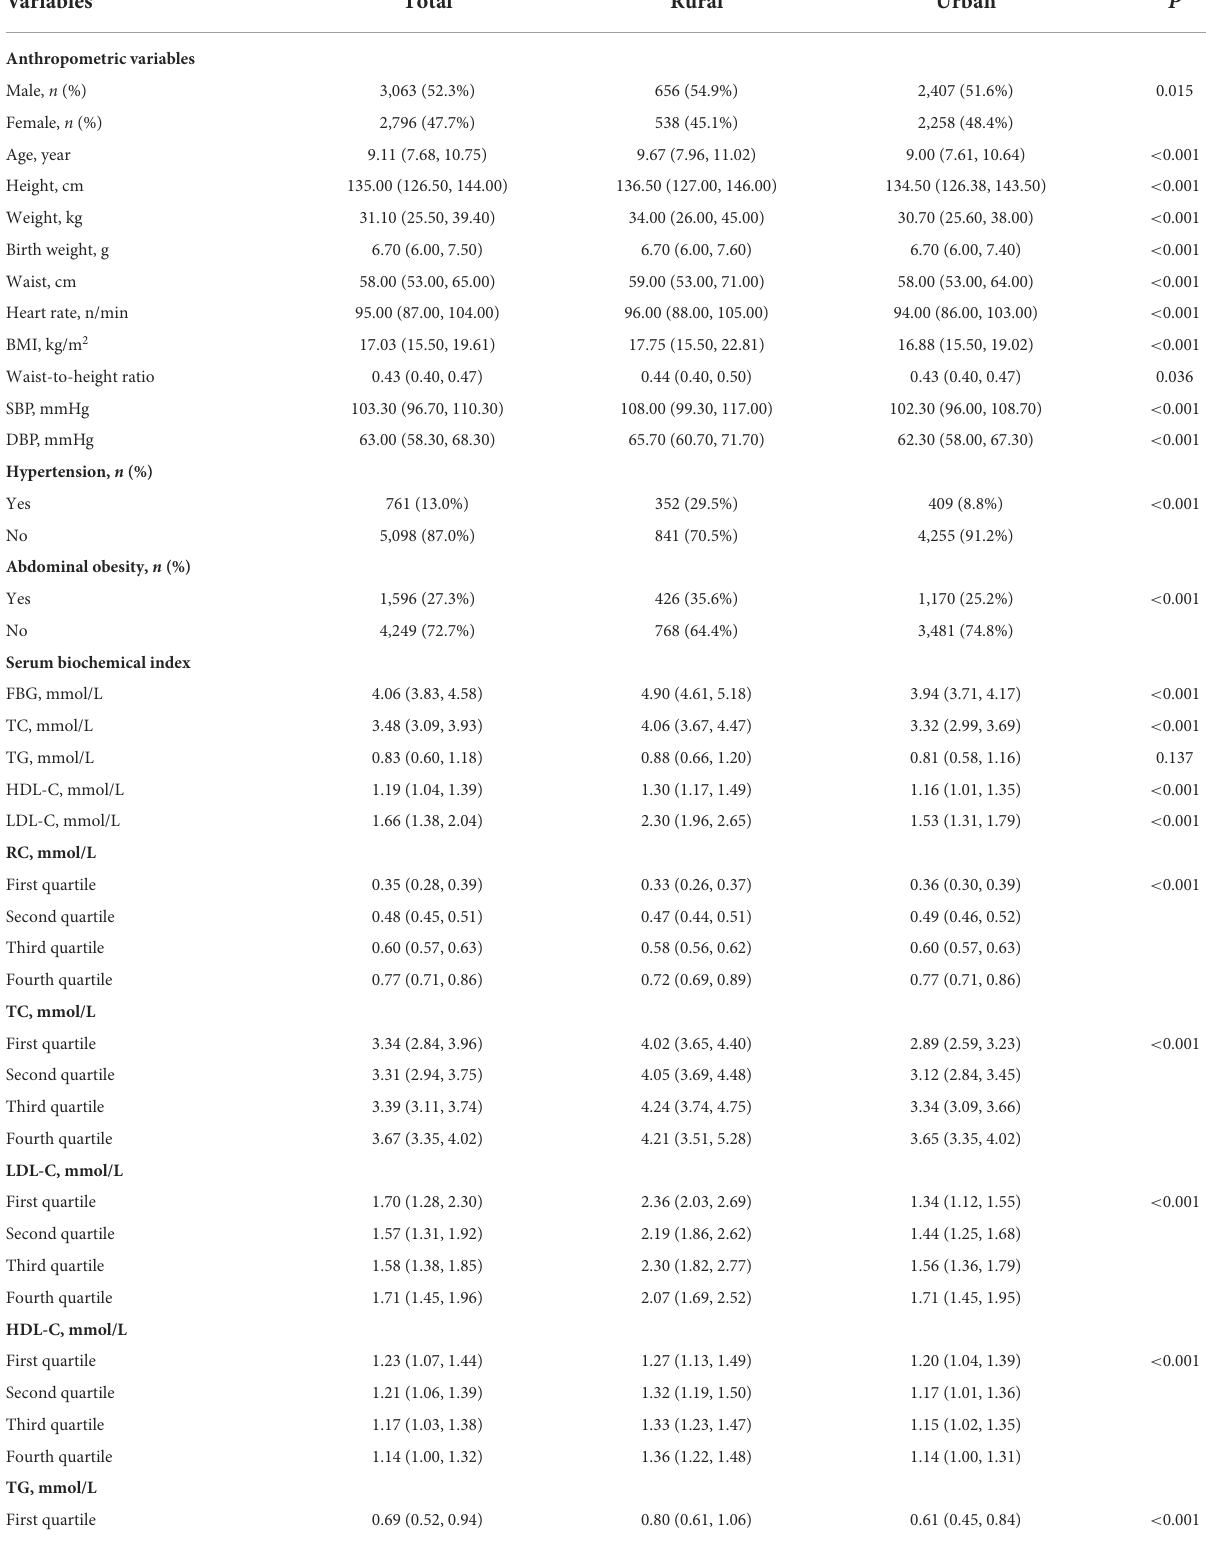
TABLE 1 The demographic characteristics of children in rural and urban